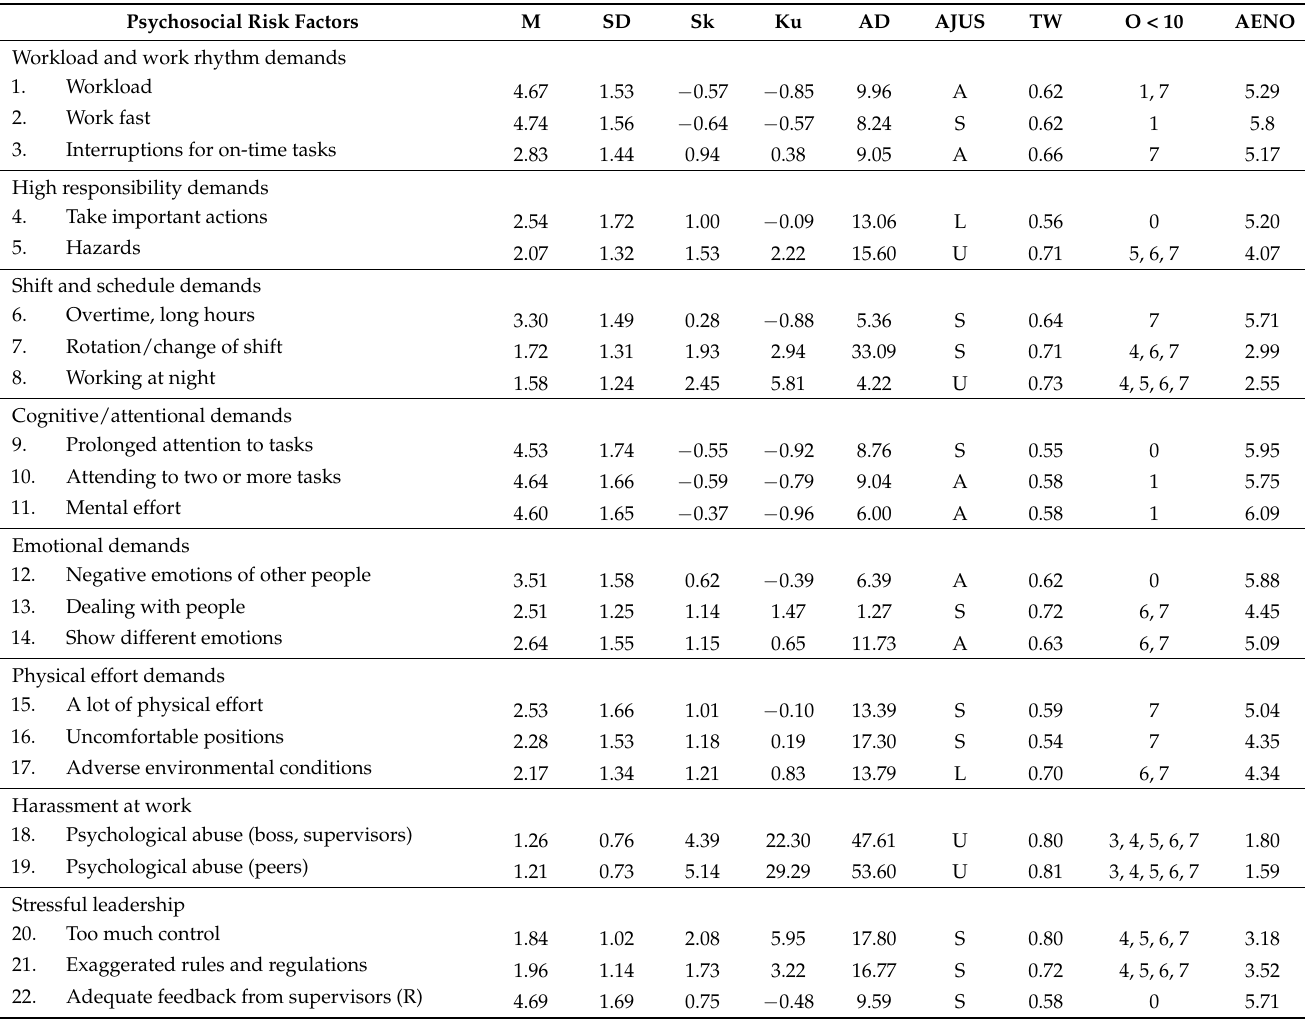
Table 2. Descriptive statistical results of the psychosocial risk factor